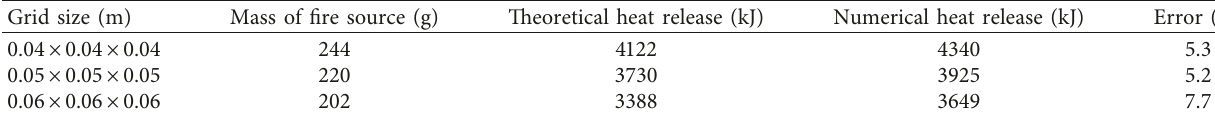
Figure 2: FDS model. Table 1: Heat release and mass source with different